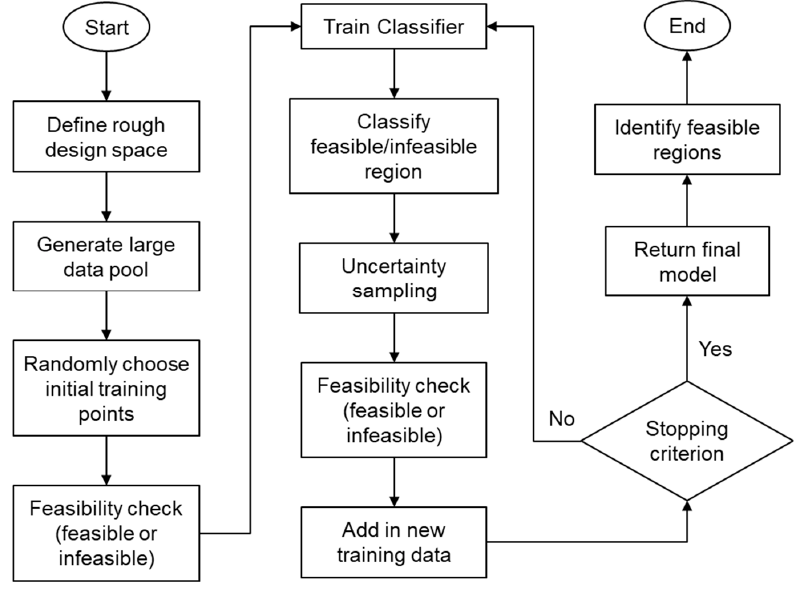
Figure 4. Flowchart of IDEM with active learning.